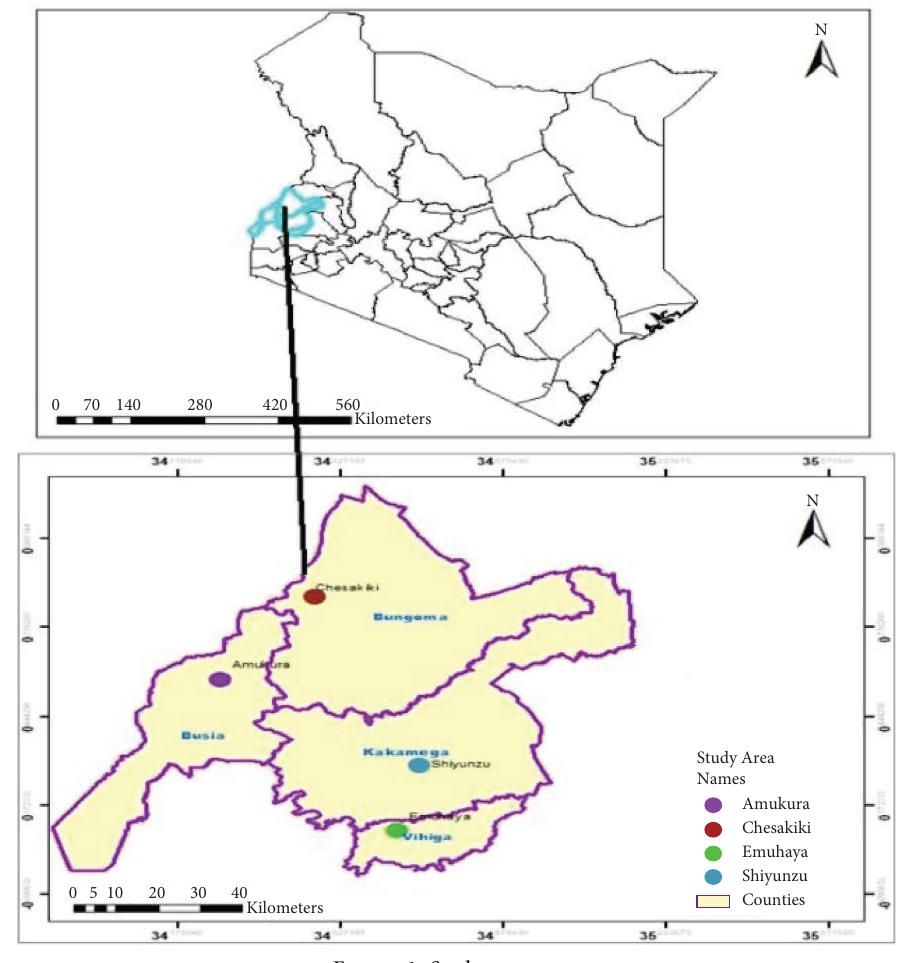
Figure 1: Study area